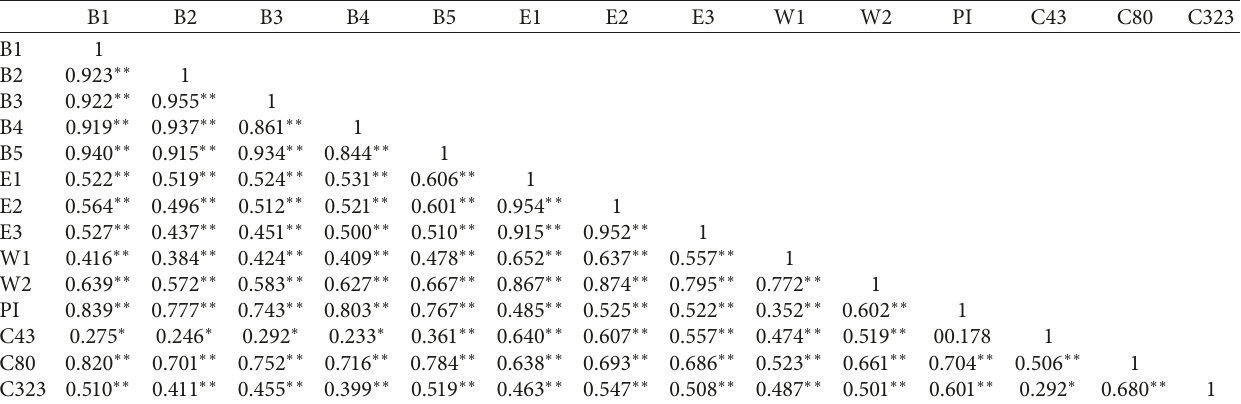
Table 4: Correlation Coefficients for PM 2.5 concentrations between the study locations and the CAMS